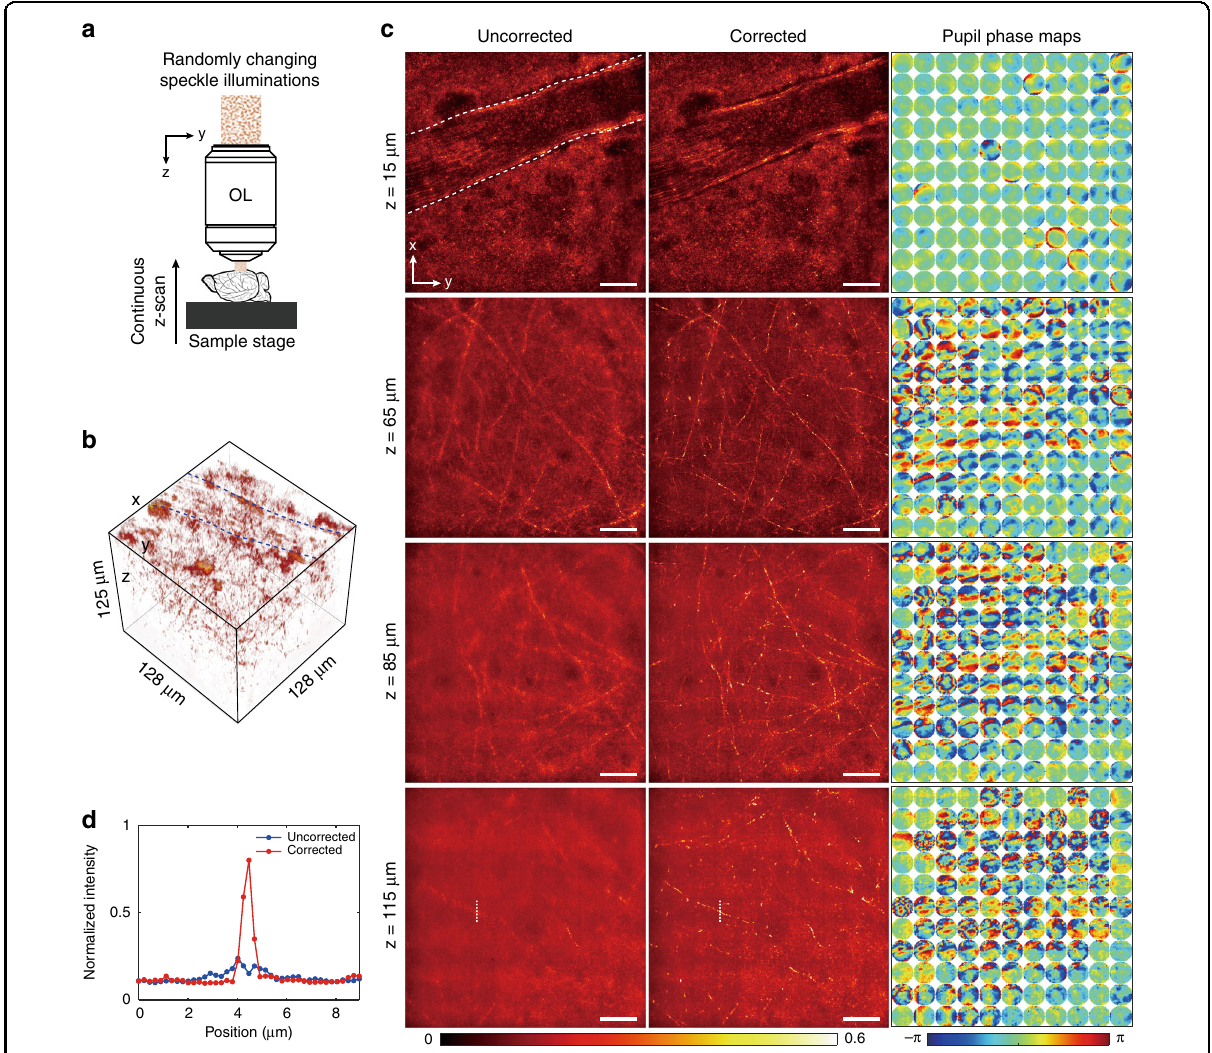
Fig. 5 Aberration-free volumetric high-speed imaging of a mouse brain. a Imaging con fi guration. The mouse brain tissue was continuously scanned along the z -axis at a constant speed while dynamically varying speckle patterns illuminated the specimen. b Reconstructed 3D volumetric image of brain tissue with transverse fi eld of view of 128 × 128 µm and depth range of 125 µm, composed of 568 × 568 × 125 voxels. The two white dashed curves indicate wall boundaries of a blood vessel with a diameter of ~30 µm, located close to the brain surface. c Left-hand and middle columns show MIP images with and without aberration correction at various depths, respectively. MIP range: 6 µm for z = 15, 65, and 85 µm, and 20 µm for z = 115 um. The right-hand column shows reconstructed output pupil phase maps for 11 × 11 subregions. The white dashed curves in the uncorrected image at z = 15 µm indicate wall boundaries of a blood vessel near the brain surface. The radius of each circle corresponds to a numerical aperture of NA = 0.94. The images at each depth were normalized by the maximum intensity in the corrected image. Scale bar: 20 µm. d Line pro fi les along the vertical white dotted lines in the images at z = 115 µm in ( b